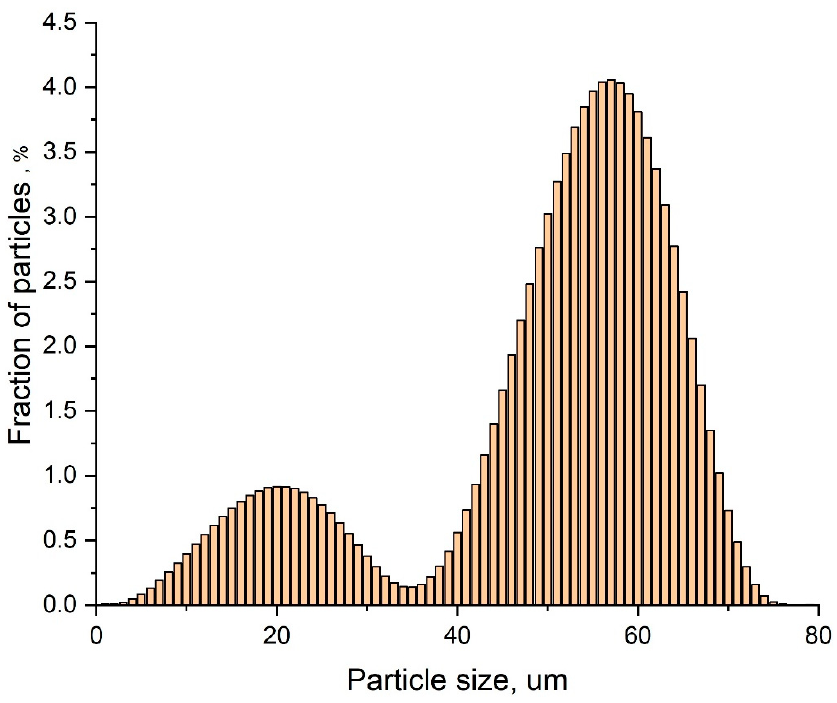
Figure 1. Particle size distribution of as-received SiC powder measured by laser diffraction. Bimodal behavior can be observed.